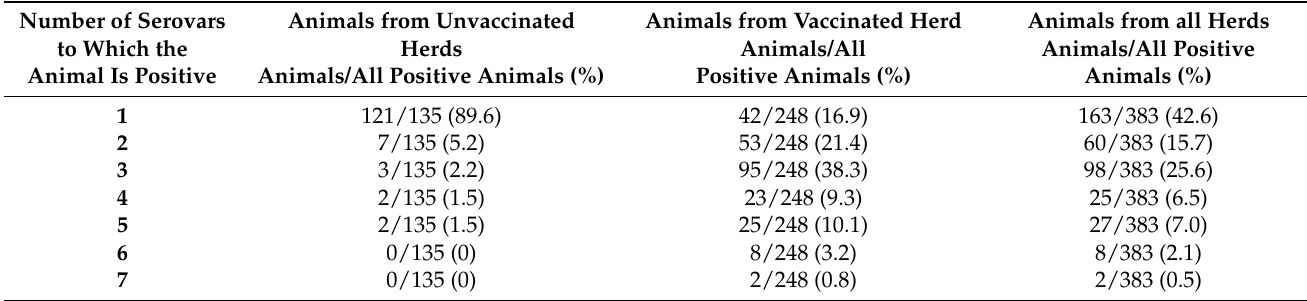
Table 3. Animals from 20 unvaccinated dairy herds and one vaccinated dairy herd in Boyac á department (Columbia) that showed single or multiple positivity to different Leptospira serovars on the microscopic agglutination test. Number of Serovars